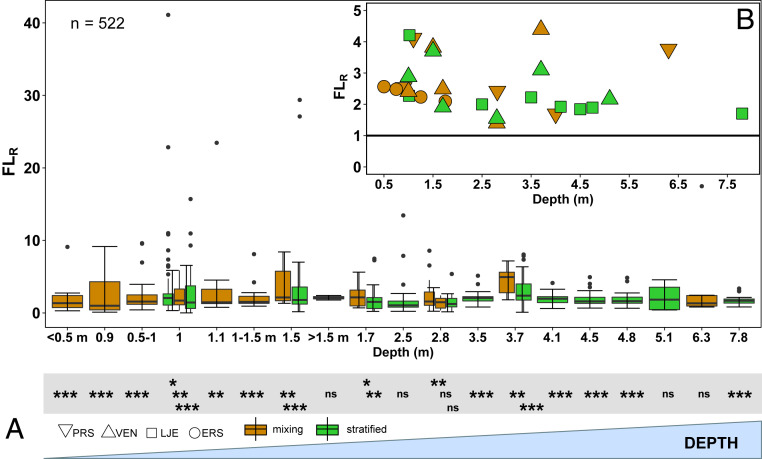
(A) Boxplots illustrating CH4 flux day:night ratio (FLR) at different depths in: PRS, ERS, LJE, and VEN lakes during mixing and the stratified period (brown and green boxes, respectively) (n = 522). The boundaries of each box plot indicate the 25th and 75th percentiles, points indicate outliers, and the solid line in each box marks the median. Asterisks (*) on the gray area below each boxplot illustrate if a given FLR was statistically higher than 1 (Wilcoxon test), indicating significantly higher fluxes during the day; *P < 0.05, **P < 0.01, ***P < 0.001, not significant (ns). The x axis indicates the depths where CH4 fluxes were measured; (B) Average CH4 flux day:night ratio (FLR) for each lake and each depth during stratified and mixing period with each lake having different symbol shapes (n = 28). The figure shows that there was no clear depth dependency of FLR.